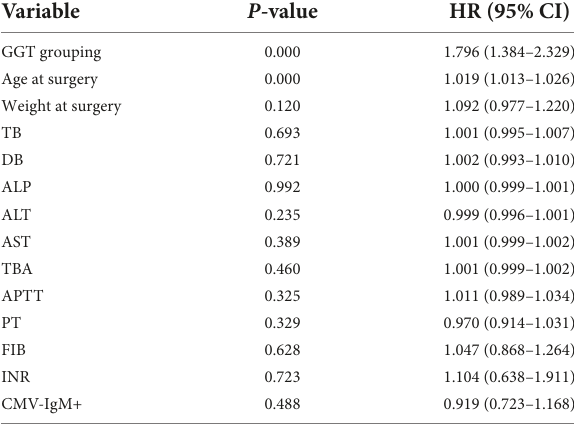
GGT, gamma-glutamyl transpeptidase; BA, biliary atresia; TB, total bilirubin; DB, direct bilirubin; ALP, alkaline phosphatase; ALT, alanine aminotransferase; AST, aspartate aminotransferase; TBA, total bile acid; APTT, activated partial thromboplastin time; PT, prothrombin time; TT, thrombin time; FIB, fibrinogen; INR, international normalized